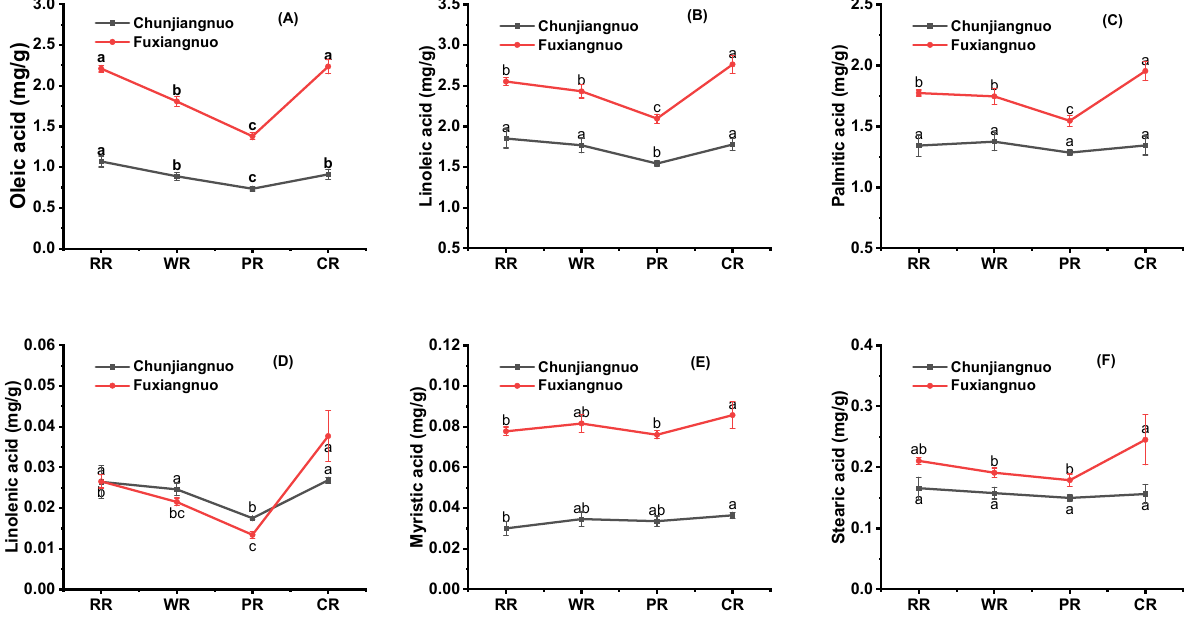
Figure 2. Changes in the fatty acids during rice cooking process. ( A ): oleic acid; ( B ): linoleic acid; ( C ): palmitic acid; ( D ): linolenic acid; ( E ): myristic acid; ( F ): stearic acid. RR: raw rice; WR: washed rice; PR: presoaked rice; CR: cooked rice. Means with the same letter were not significantly different ( p < 0.05).